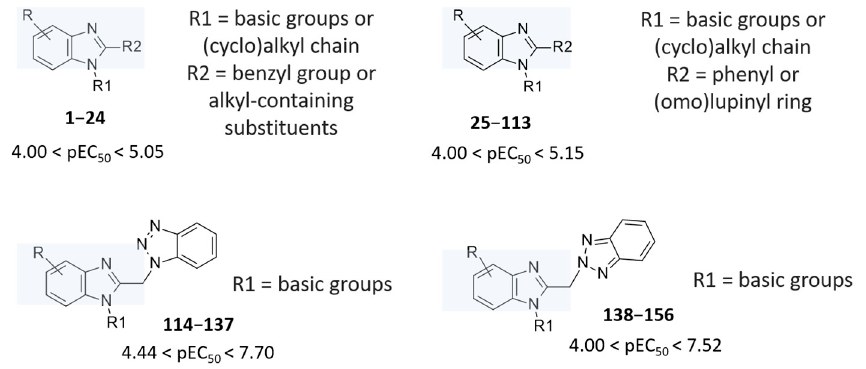
Figure 2. In-house series of computational studies of benzimidazoles featuring anti-RSV ability. The R group represents halogen atoms, nitro group, or alkyl substituents.